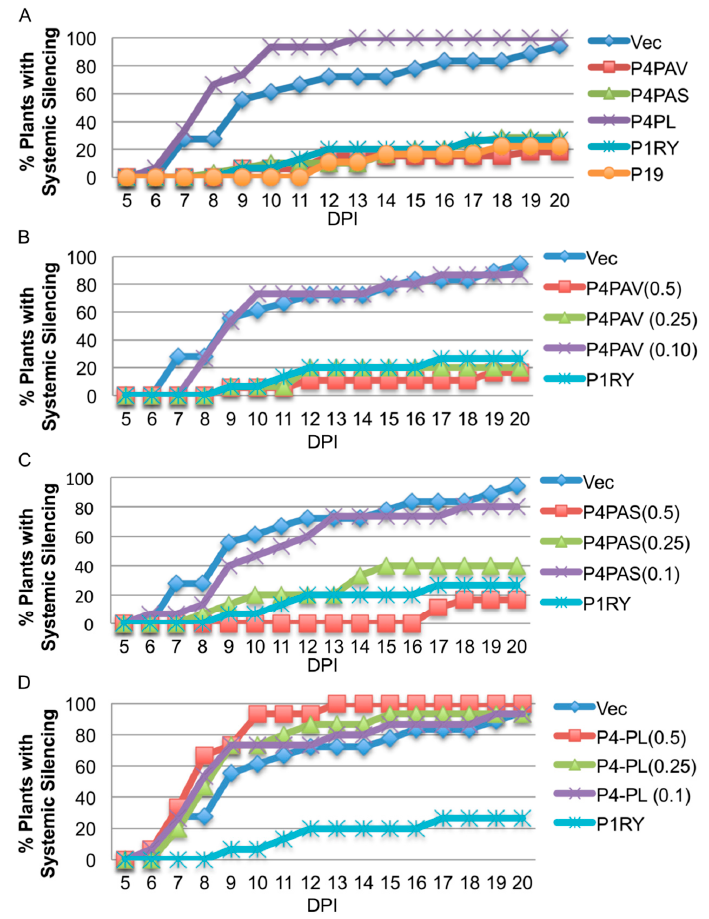
Figure 5. Dose-dependent systemic silencing suppression activities of the luteovirus P4 proteins.